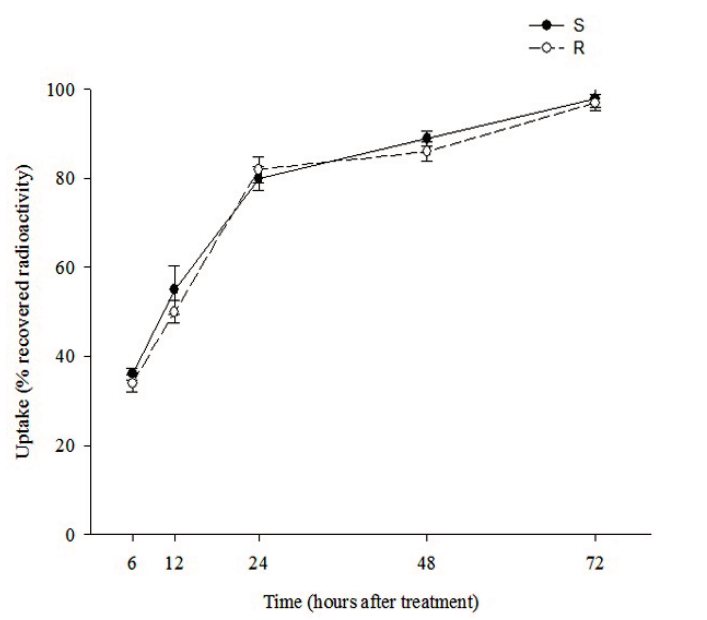
Figure 1. Uptake of Diclofop-Methyl (DM) in two biotypes of P. minor : Susceptible (S) and resistant